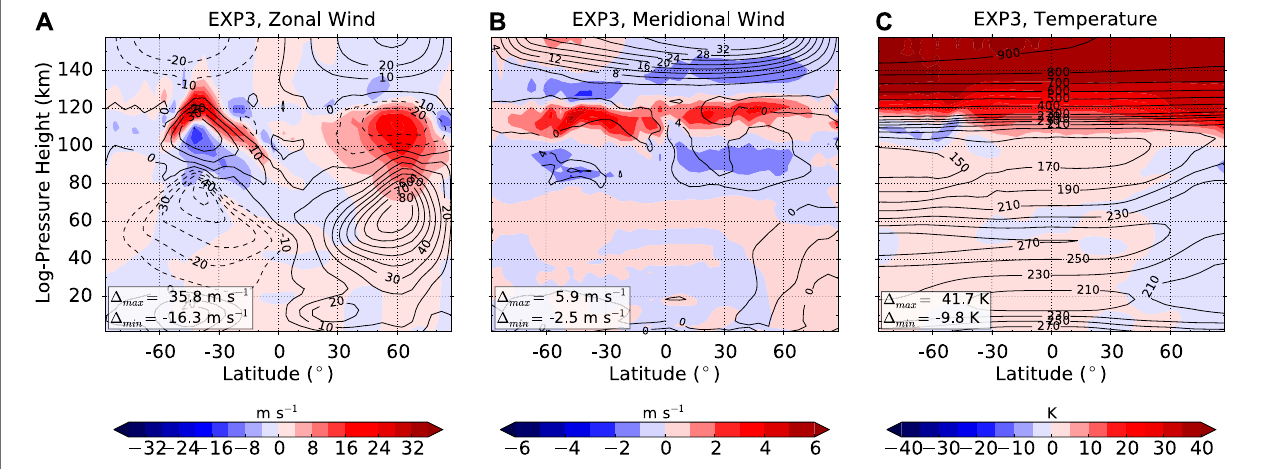
FIGURE6| Contourlines:Zonalmean (A) zonalwind, (B) meridionalwindand (C) temperatureforEXP3simulationinintervalsof (A) 10m s − 1 , (B) 4m s − 1 ,and (C) 20 K below 300 K and 100 K above. Color shading: differences